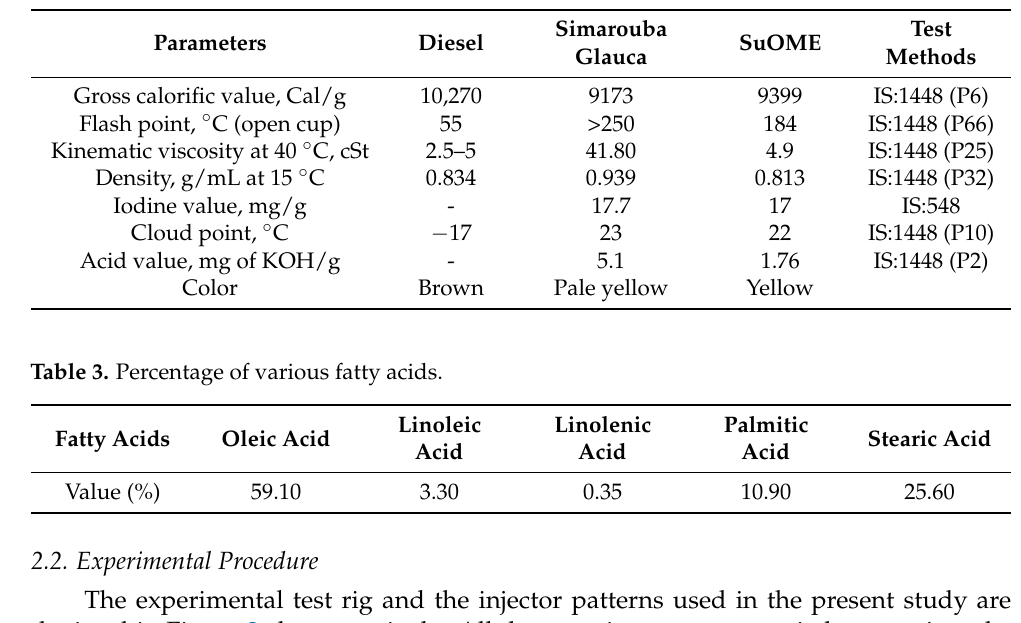
Table 2. Properties of fuel samples used in the present study [45].